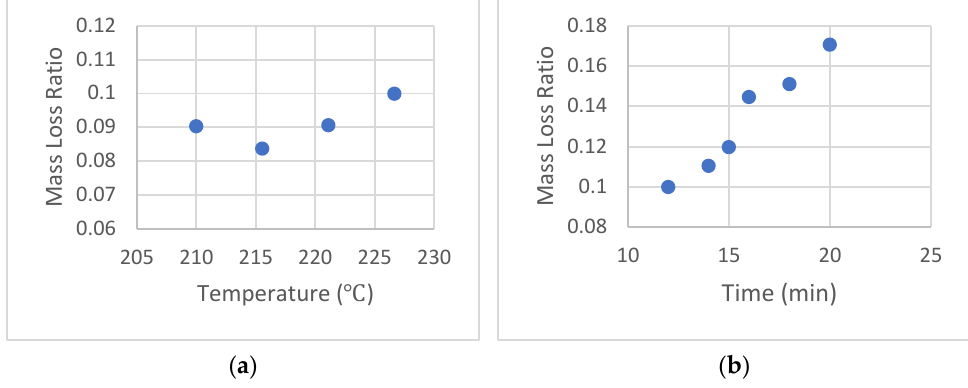
Figure 12. MLR for 9.5 kGy gamma dosed PLA 4043D resins ( a ) MLR-temperature profile held under 6672 N (1500 lbF) for 12 min ( b ) MLR-time profile held under 6672 N (1500 lbF) at 227 °C (440 °F).